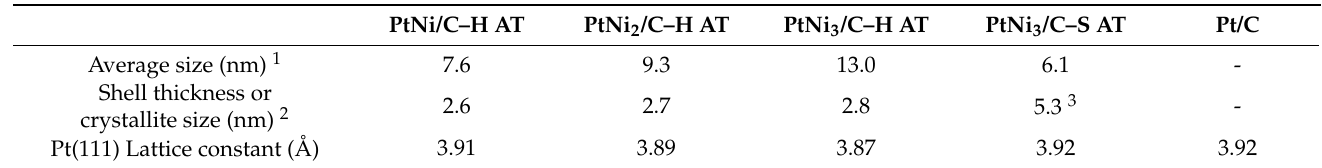
Table 2. Particle average size, shell thickness, and lattice constant of PtNi x /C AT.